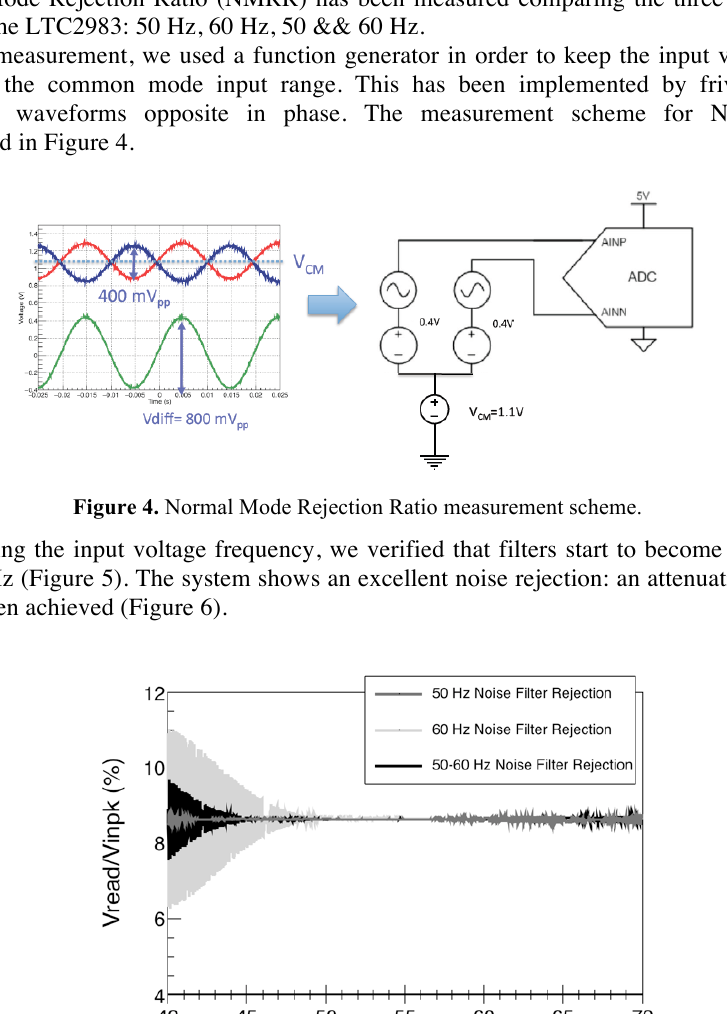
Figure 3. Common Mode at 1.1 V input with and without 40 m length cable.